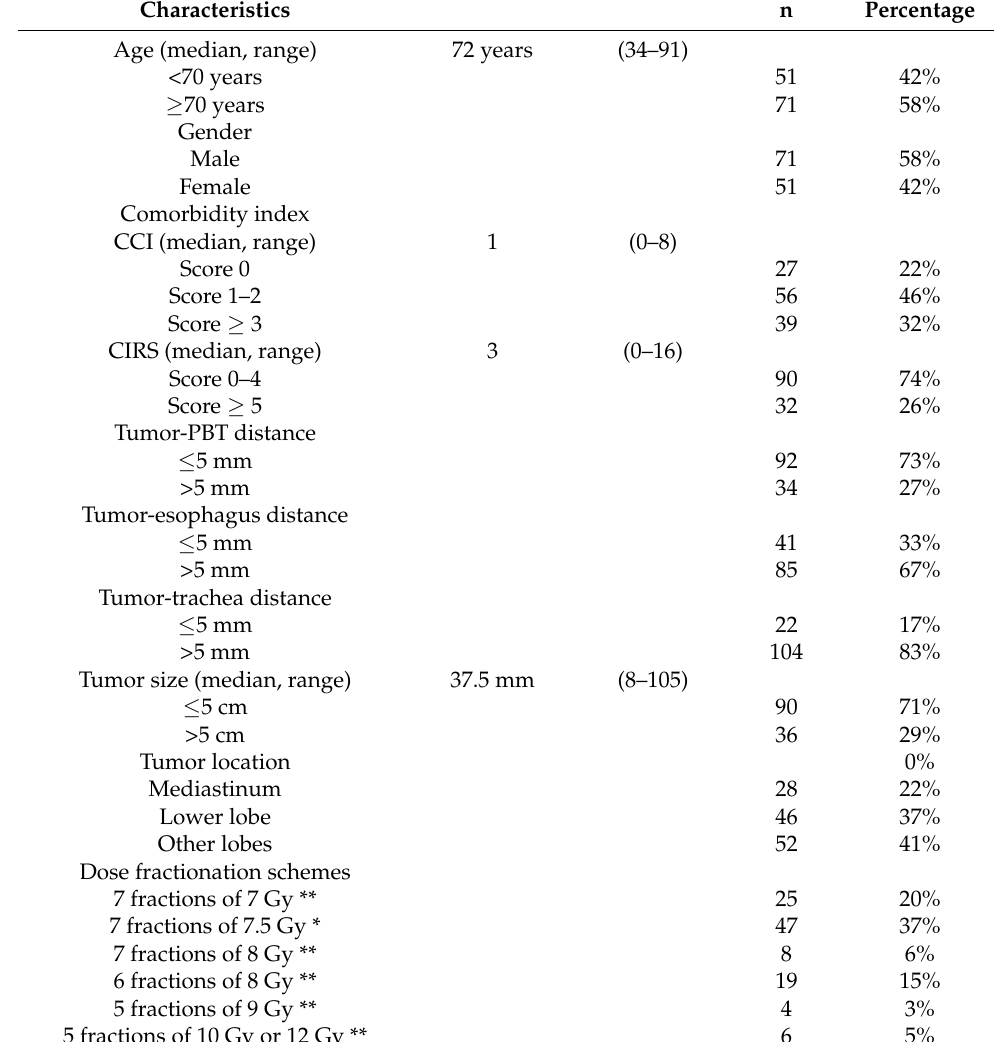
Table 2. Patient, treatment and tumor